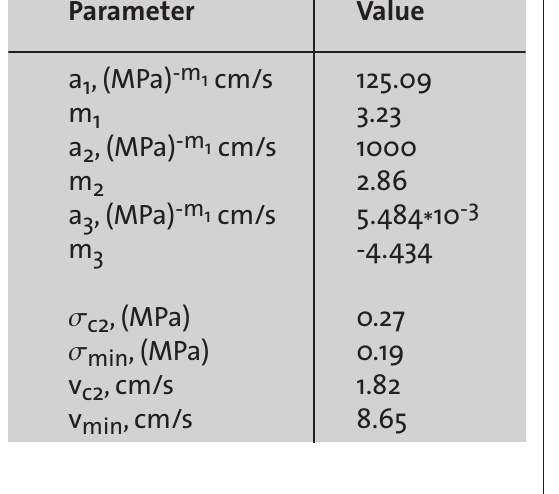
Figure 2: The nonmonotonic slip law based on the experimental data of Hatzikiriakos and Dealy with a high-density poly- ethylene at 180˚C [13,